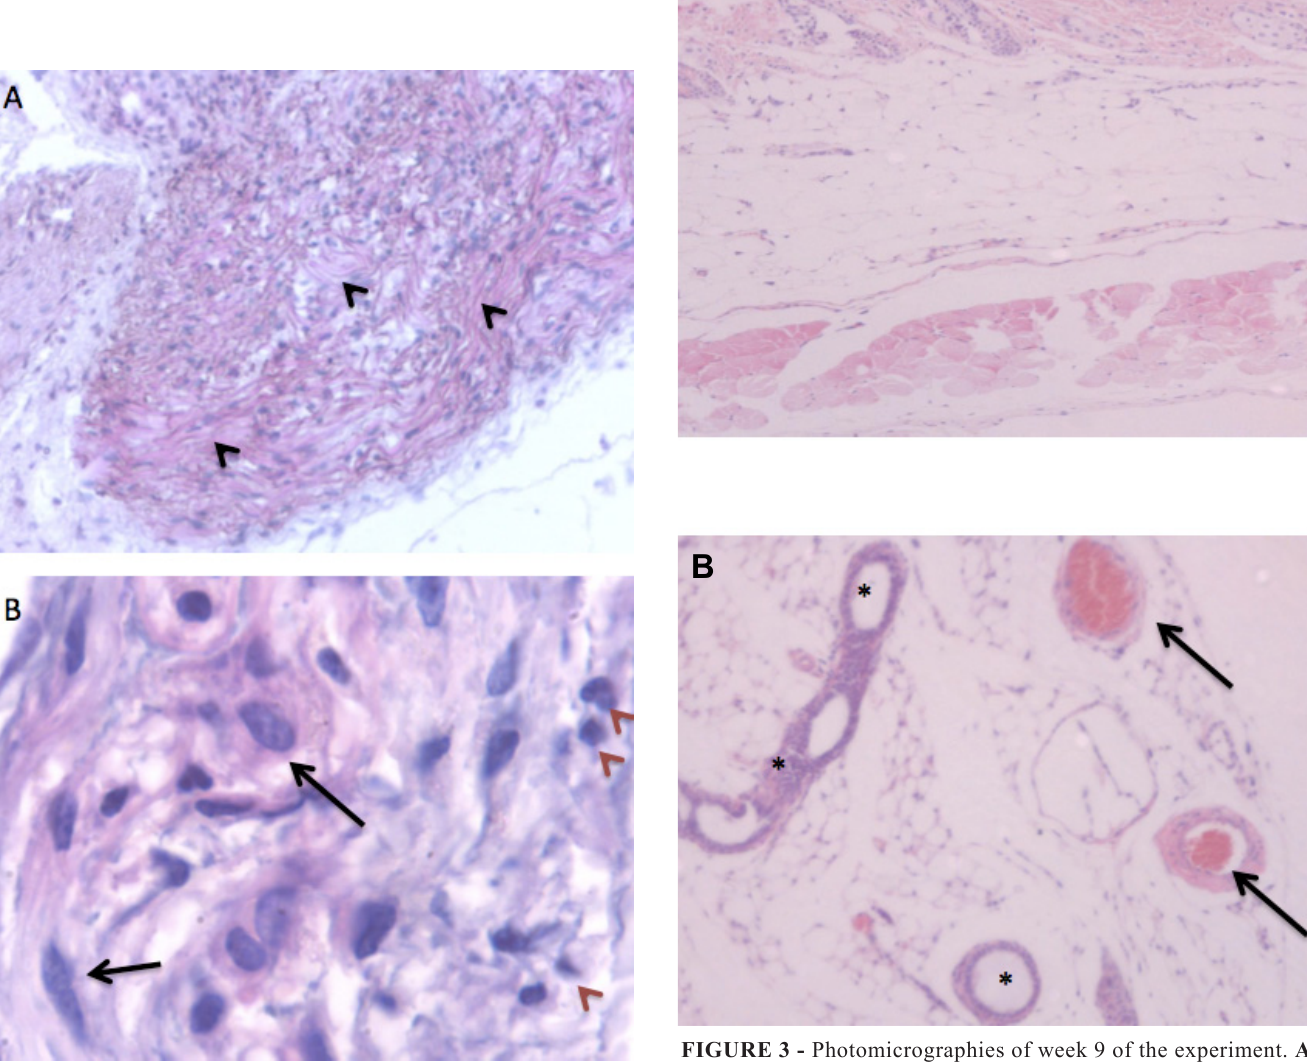
FIGURE 2 - Photomicrographies of week 3 of the experiment. A ) Presence of intense inflammatory infiltrate, rich in mononuclear cells involving the fibers of the PPM that is quite disorganized (tip of black arrow). B ) Intense presence of fibroblasts (arrow) and macrophages (tip of red arrow) in granulation tissue. HE stains. Zoom: 40x ( A ) and 100x ( B ). PPM: porcine peritoneum